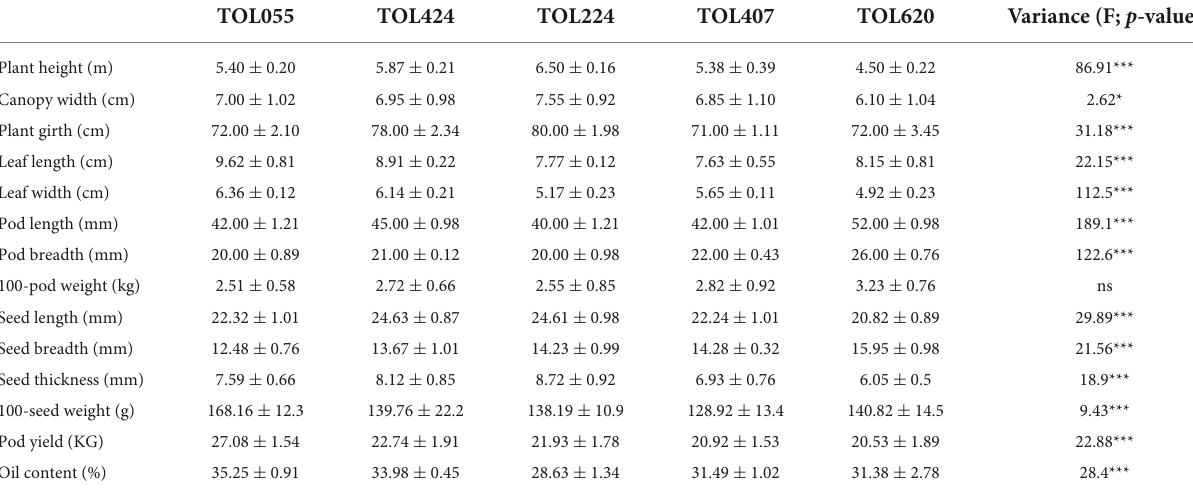
TABLE 1 Morphological, phenological, and reproductive yield characteristics of pongamia.